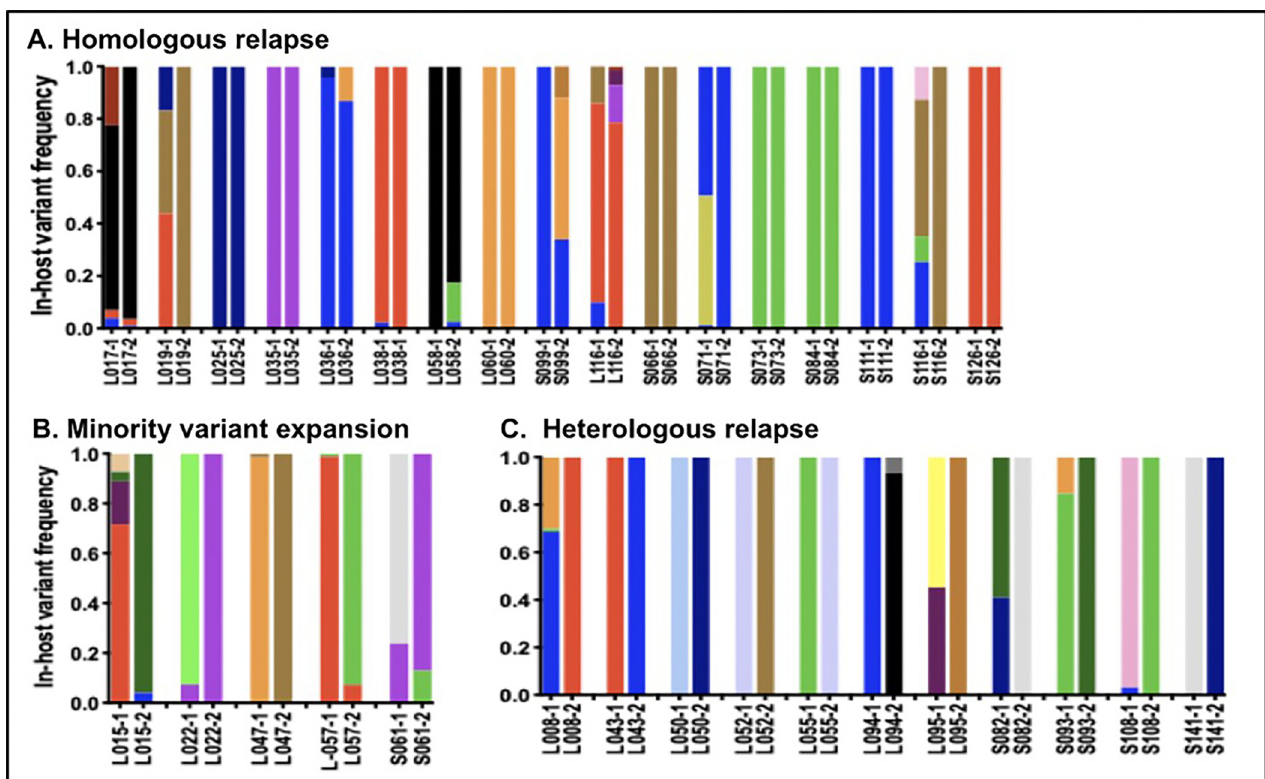
Fig 1. Genotypes of 33 pairs of relapses in returning Indonesian soldiers based on pvmsp1 amplicon deep sequencing. The in-host frequency of different pvmsp1 haplotype variants is displayed for the first (-1) and second relapse (-2) in each individual. 17 pairs showed a homologous relapse pattern (A), 5 demonstrated minor variant expansion (B), and 11 were heterologous relapses (C). Though 61% of relapses were monoclonal, only 24% had a single variant detected across both relapses. Examples of each relapse pattern are shown in